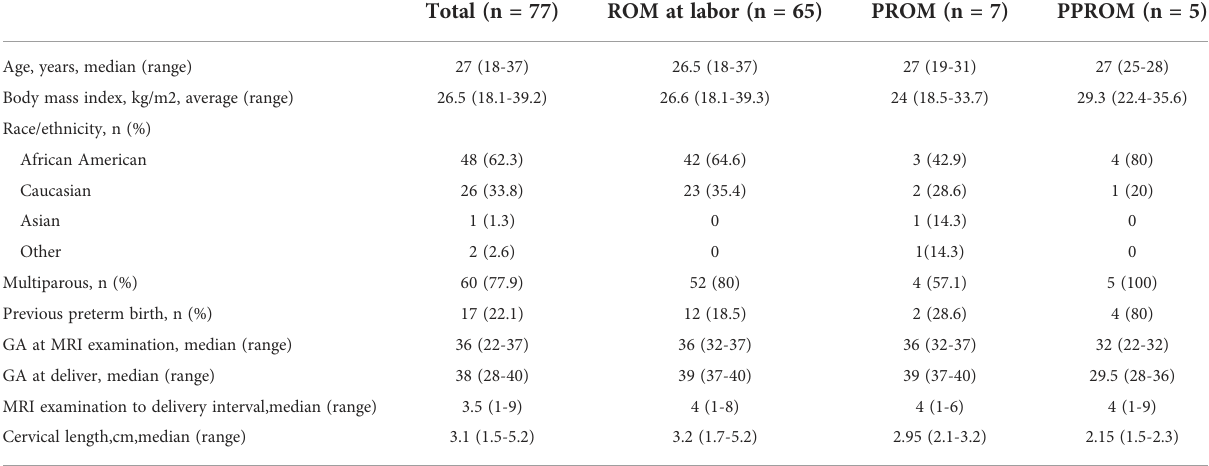
TABLE 1 Demographics of the study population.